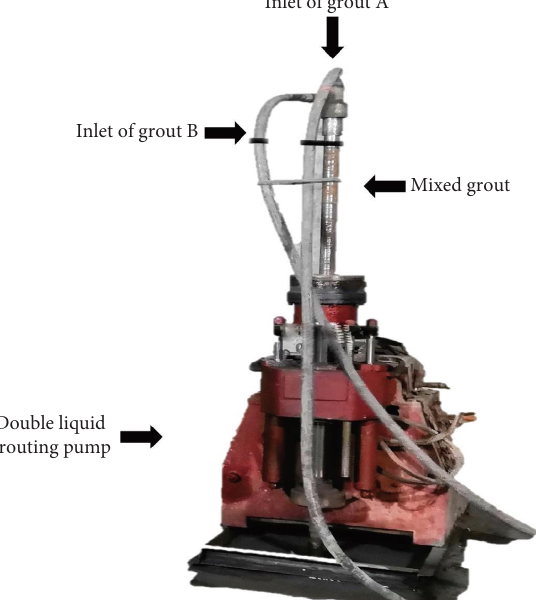
Figure 2: Double liquid grouting pump and the mixing method.